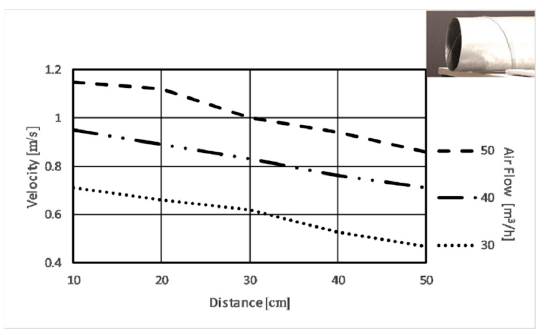
Figure 3. Mean air velocities in the case of D = 100 mm air duct.